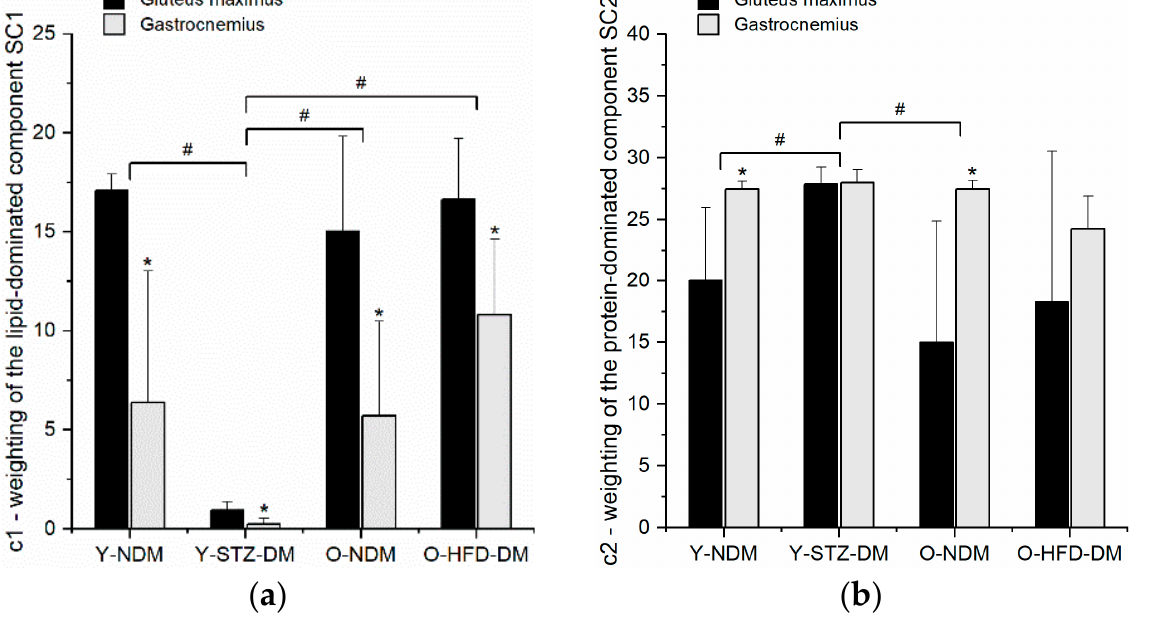
Figure 4 . The values of c 1 ( a ) and c 2 ( b ) for the gluteus maximus and gastrocnemius muscles of 13-week-old non-diabetic mice ( n = 9) (Y-NDM), 13-week-old STZ-induced diabetic mice ( n = 9) (Y-STZ-DM), 54-week-old non-diabetic mice ( n = 9) (O-NDM), and 54-week-old HFD-induced obese insulin-resistant mice ( n = 9) (O-HFD-DM). Data are means and standard deviation (SD); # p < 0.05 for comparison between study groups and * p < 0.05 for comparison of gluteus maximus vs. gastrocnemius in the same study group (two-way ANOVA with repeated measures).